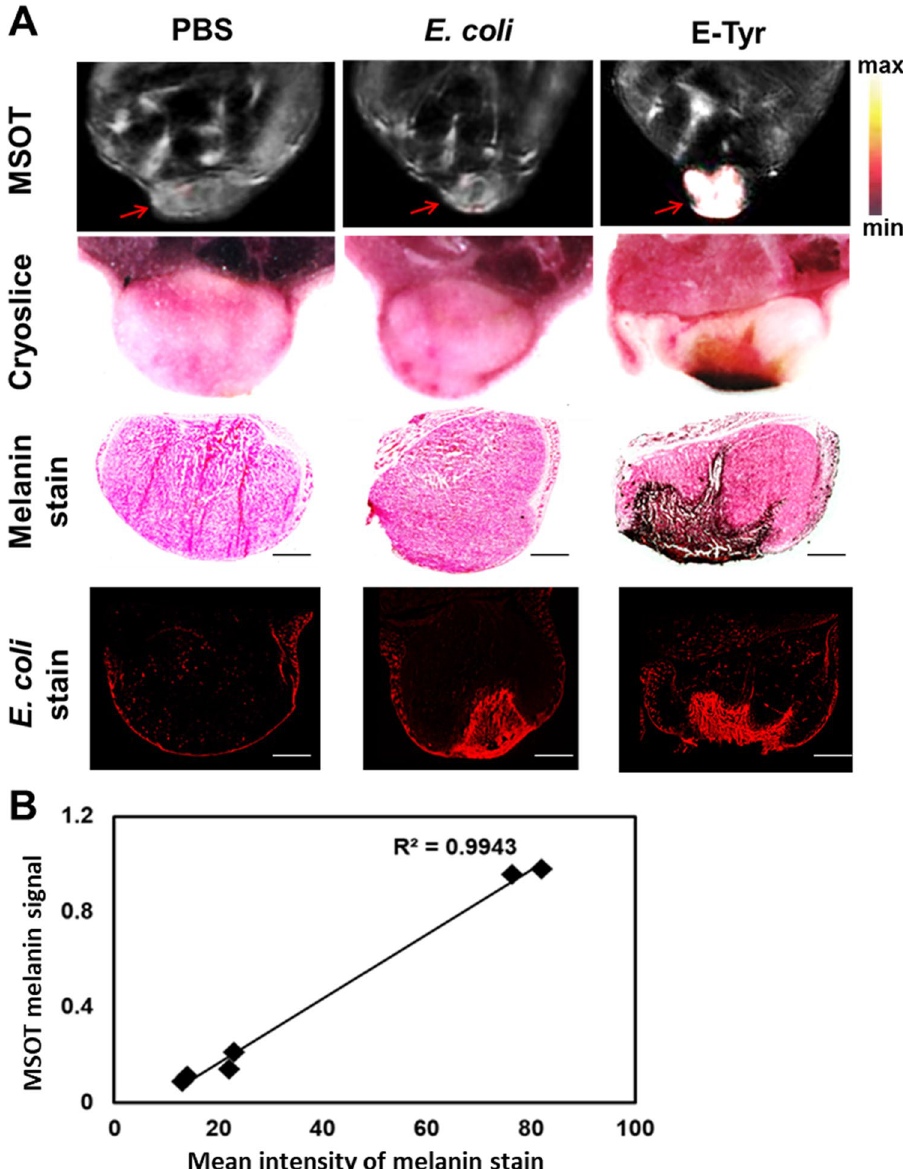
Figure 3. Correlation between tumor optoacoustic melanin signal in vivo and the distribution of melanin in tumor cryo sections. ( A ) MSOT images of melanin signal using CT26 tumor-bearing live mice 24 h after E-Tyr injection (Top). Cyro-slice image of tumors. Tumors were assessed by specific melanin staining (darkbrown, middle) using the Fontana-Masson stain and E. coli stain (red fluorescence, bottom) with a specific E. coli antibody. High magnification (× 100) images of melanin and E. coli stains were obtained using the software ZENblue (CarlZeiss). ( B ) Correlation of the melanin signal of MSOT (24 h) and the mean intensity of melanin stain by the Pearson correlation method (R 2 = 0.9943, n =